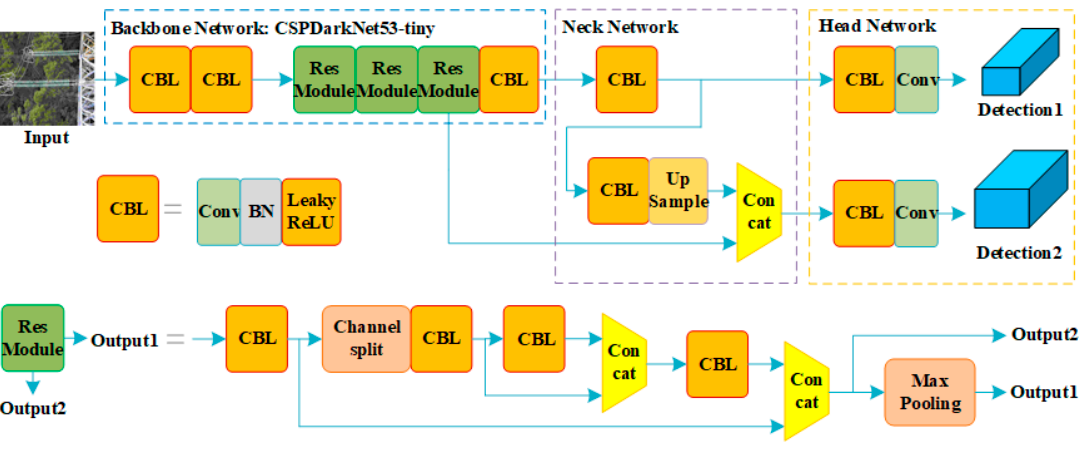
Figure 1. YOLOv4-tiny network structure.